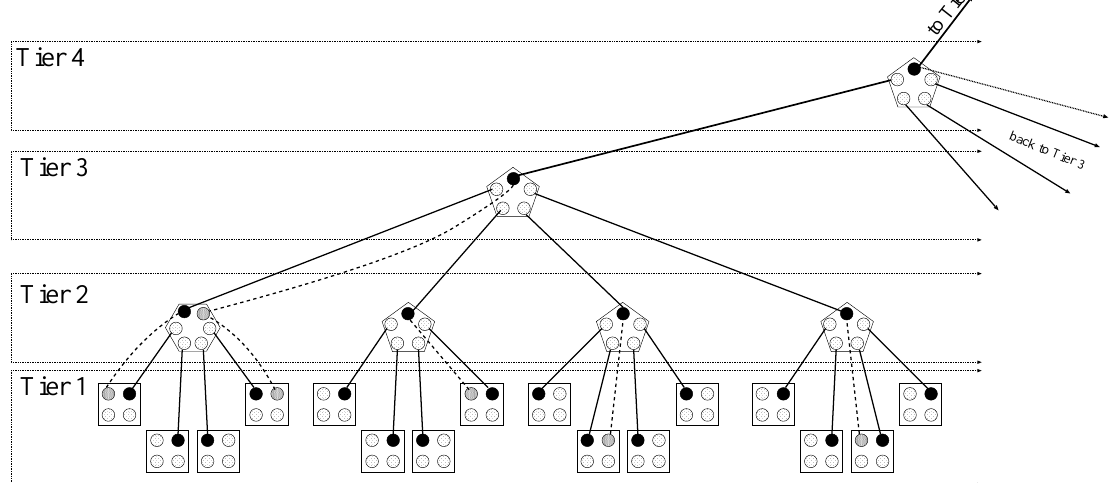
Figure 1: A fragment of a pyramidal democracy. For simplicity I assume B = 4. Polygons are nodes, and circles are their members. White circles are ordinary members (who can vote). Black circles are delegates (who cannot vote in their home node). Grey circles are metadelegates. Solid lines represent delegacy; dashed lines represent